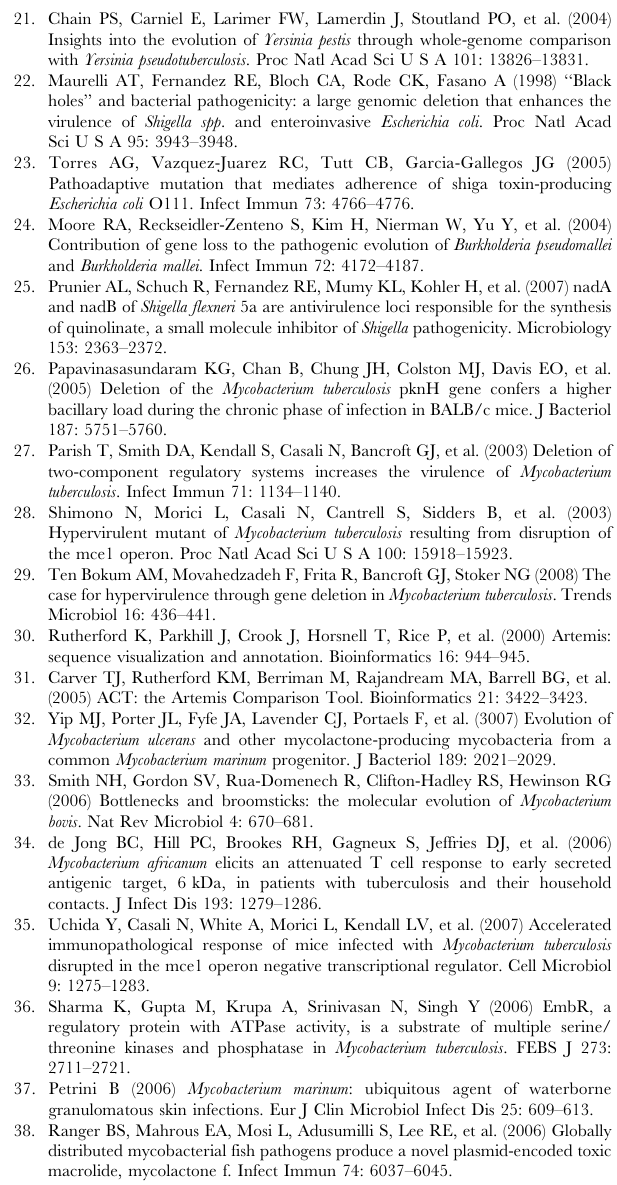
Table S1 CDSs inactivated in RDs1 through 15 across the M. ulcerans haplotypes. CDSs are listed in the order of the M. marinum annotation. Note that only CDSs are listed where M. ulcerans haplotypes differ from each other. Thus, not all MURDs distinguishing the classical lineage from M. marinum in these regions are mentioned but are found elsewhere [11]. All CDSs deleted in more than one haplotype were lost in independent events except when indicated (*= probably not independently deleted). When deleted or pseudogenized, CDSs are indicated in the M. ulcerans Agy99 annotation, where possible, and in the M. marinum M annotation where no M. ulcerans orthologue exists. When found present, respective CDSs are indicated as